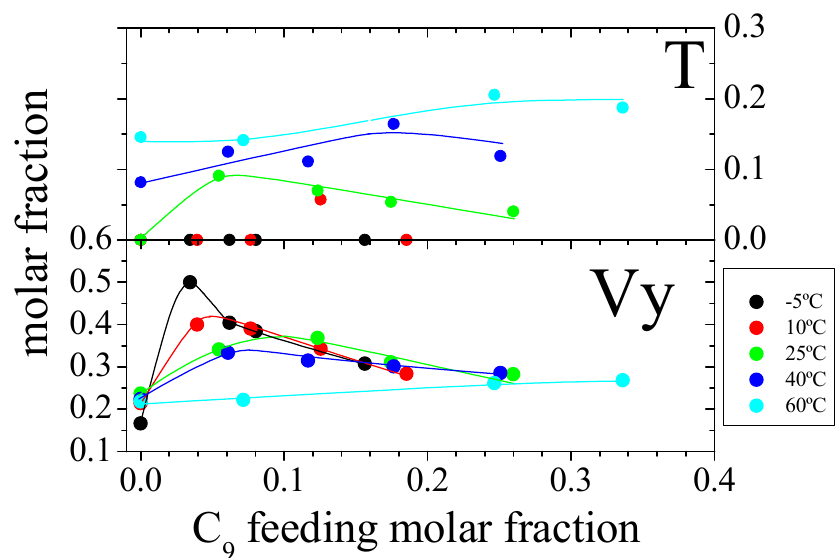
ff erent series.